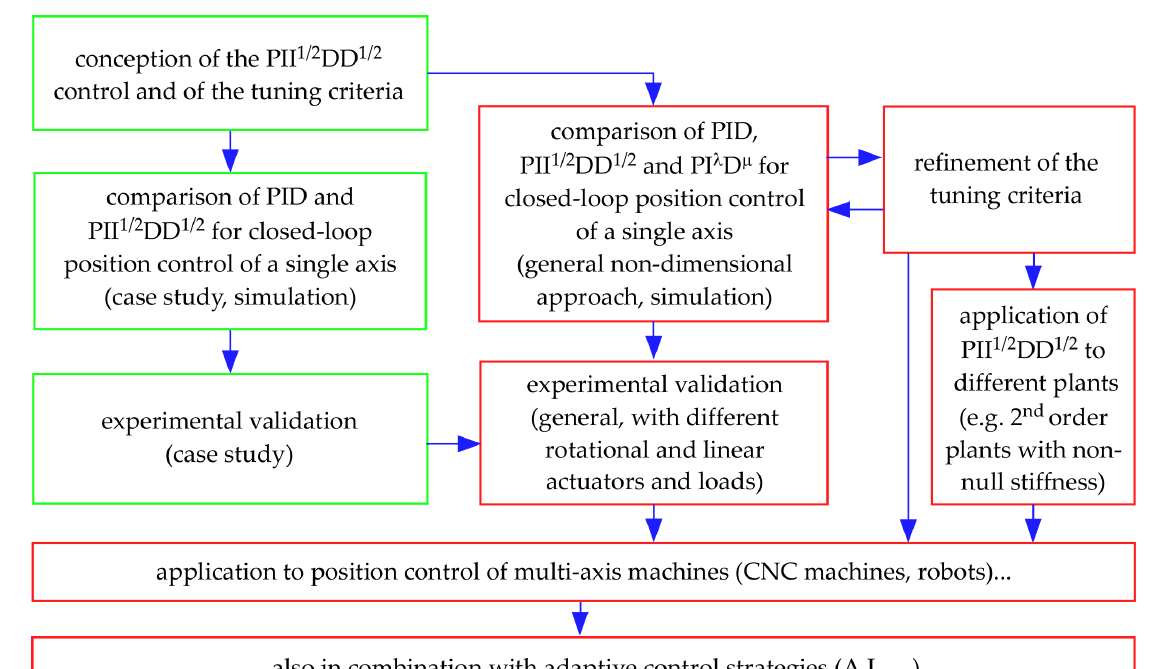
Figure 14. Block diagram of the research methodology and future research directions (green blocks: present achievements; red blocks: prospective